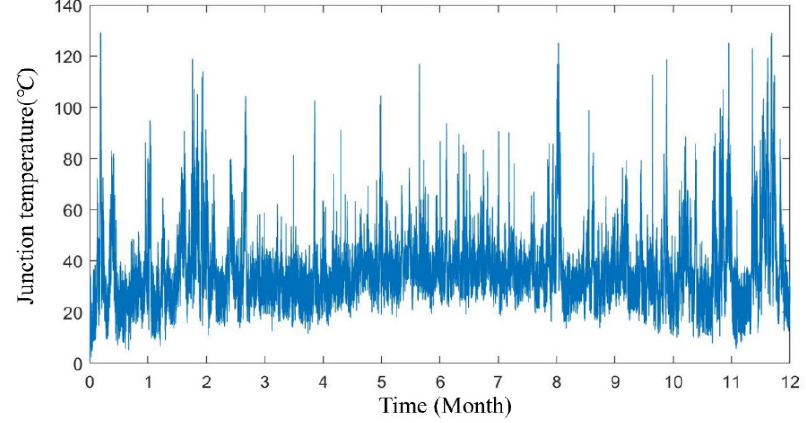
8 of 21 Figure 4. Junction temperature calculation process.